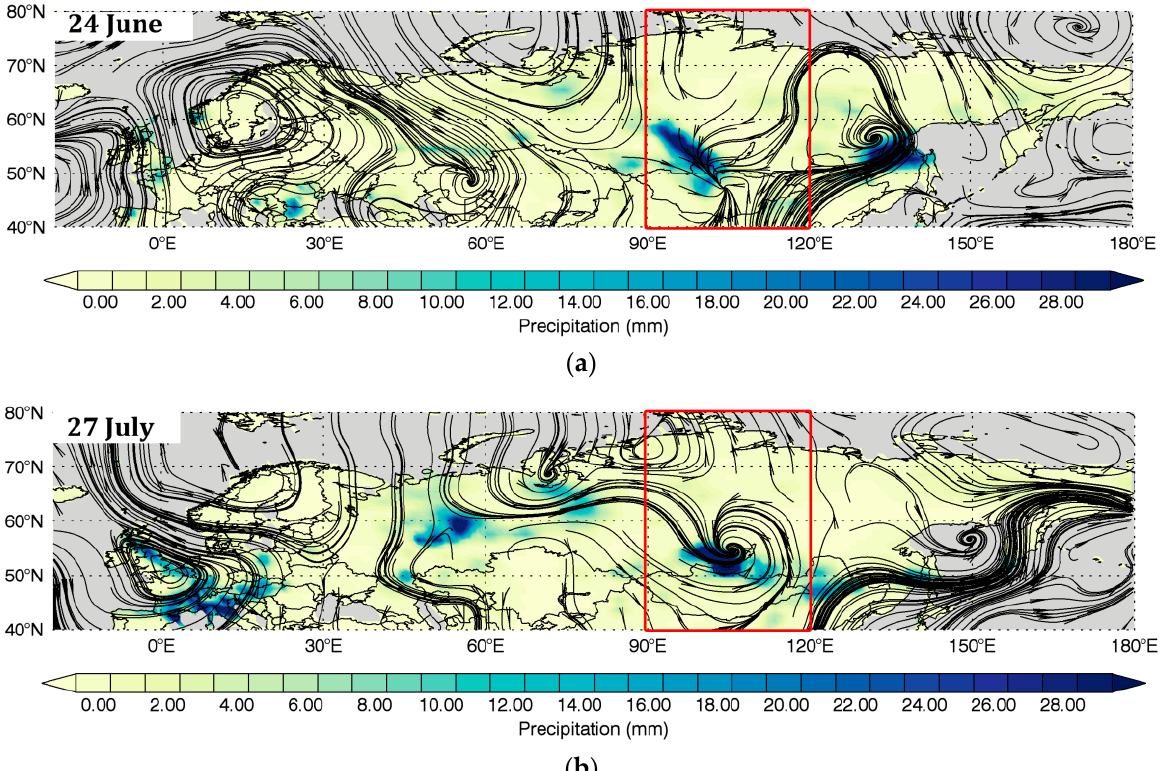
Figure 5. The total amount of precipitation and daily streamline for the first flood wave (( a ) 24 June) and for the second flood wave (( b ) 27 July). The red color—the region of interest. Era-Interim data, at 850 hPa.